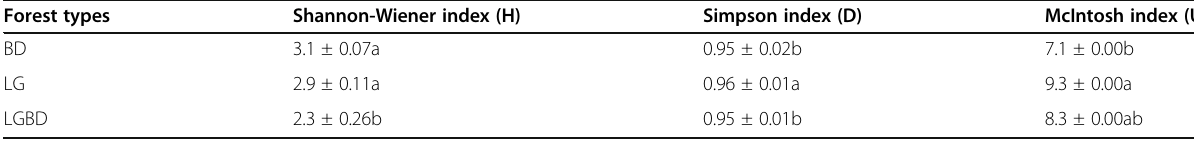
Table 2 Soil microbial functional diversity of carbon utilisation Forest types